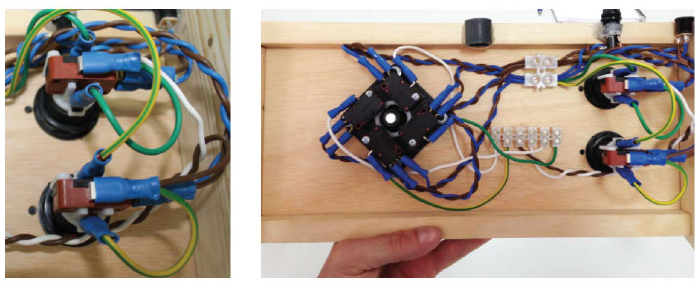
Figure 10. Assembly of wire connections to the back side of the